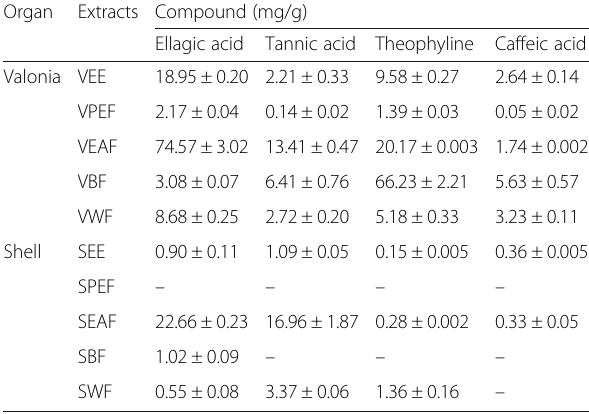
Table 3 Contents of four compounds of valonia and shell extracts from Q. variabilis Organ Extracts Compound (mg/g)